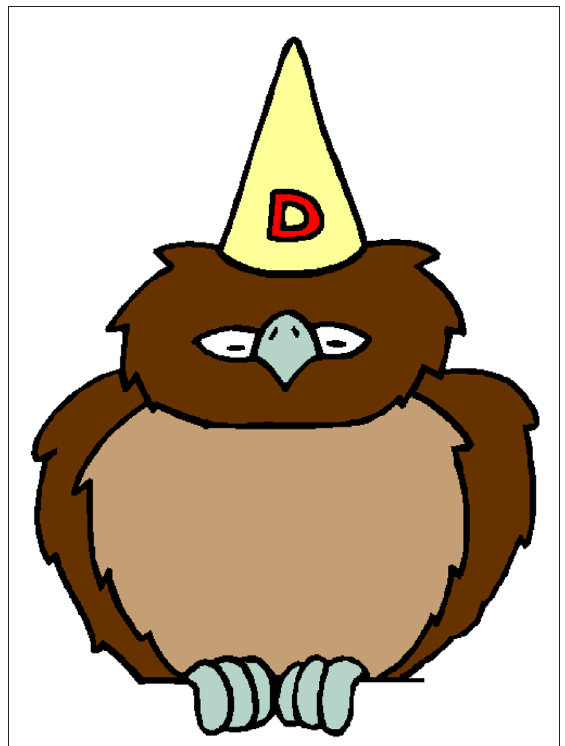
Figure 3: Clip art image used to produce ‘Fungus